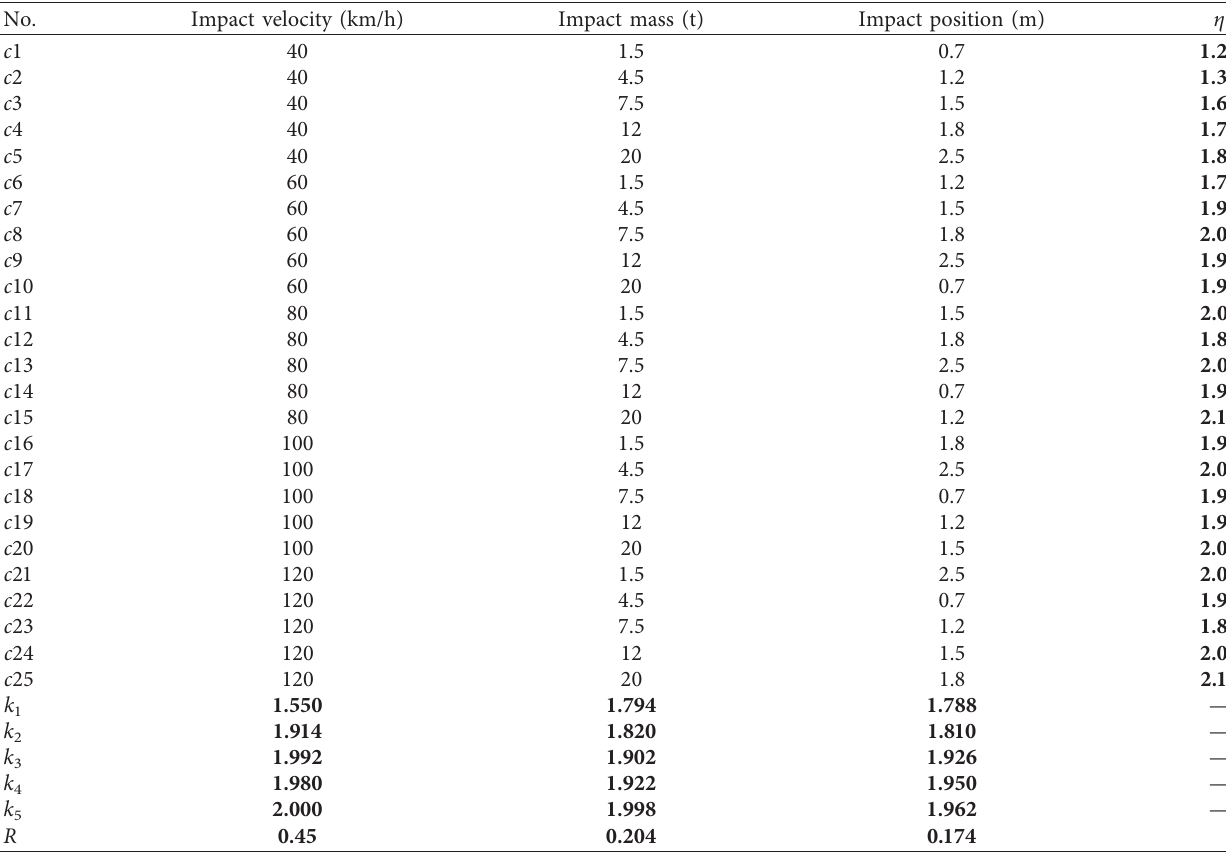
Figure 11: Vertical displacement of the failure column node versus time ( T ) curves. Table 3: Summary of data analysis on transverse impact